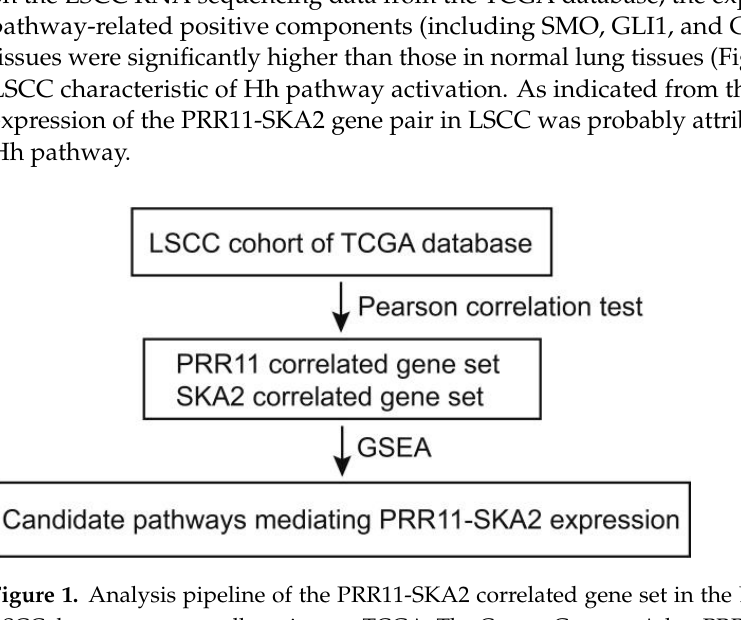
Figure 1. Analysis pipeline of the PRR11-SKA2 correlated gene set in the LSCC cohort of TCGA. LSCC, lung squamous cell carcinoma; TCGA, The Cancer Genome Atlas; PRR11, proline-rich protein 11; SKA2, spindle, and kinetochore associated 2.